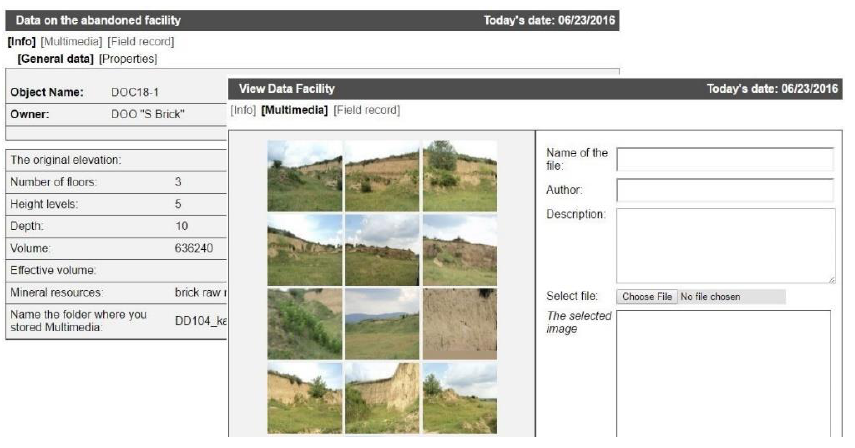
Figure 5. The panels showing basic information and multimedia data fora mine.